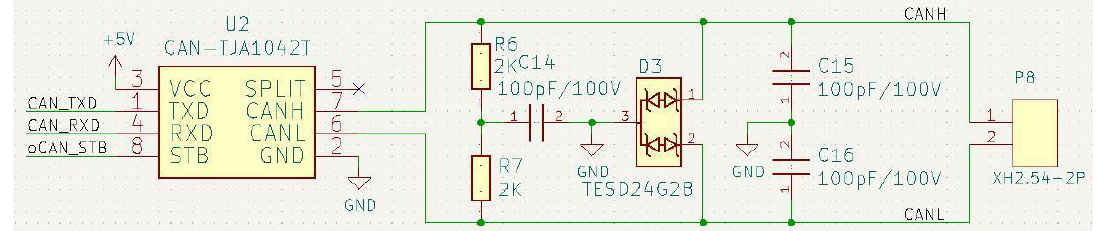
Figure 10. Schematic diagram of the CAN communication circuit.